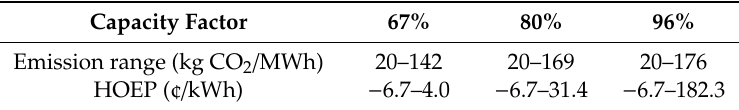
Table 4. Ranges of hourly emission factors and hourly Ontario energy price for the three capacity factors